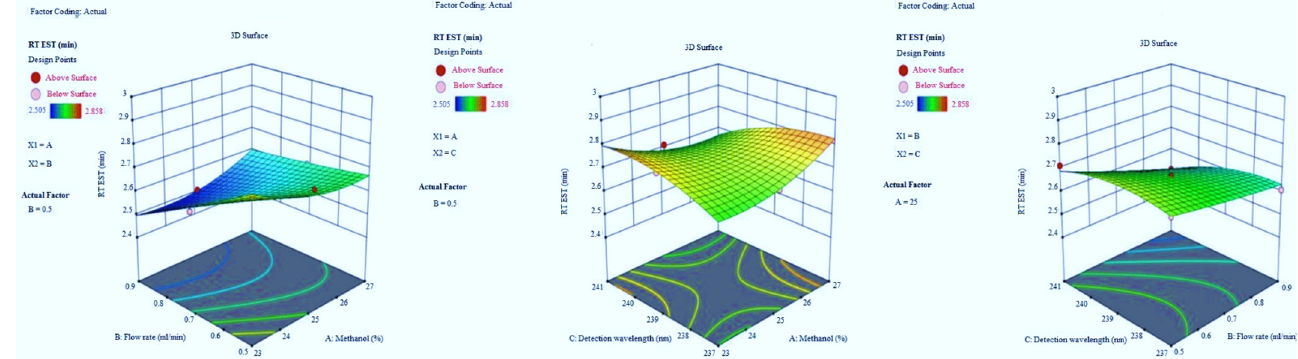
Figure 3. 3D responses for EST retention time in terms of AB, AC, and BC.